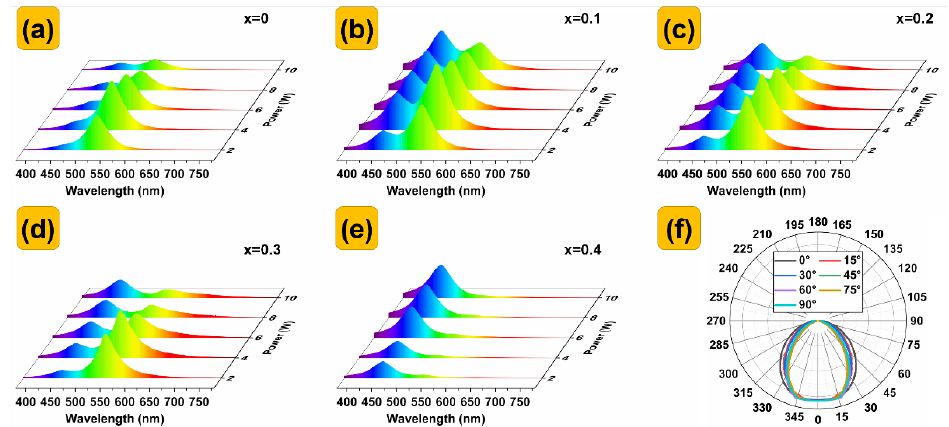
Figure 7. ( a – e ) EL spectra of Cs(Pb,Mn)Br 3 PQDs@glasses with different Mn 2+ doping concentrations. ( f ) Light distribution curves of the blue LEDs encapsulated with Cs(Pb,Mn)Br 3 PQDs@glasses.